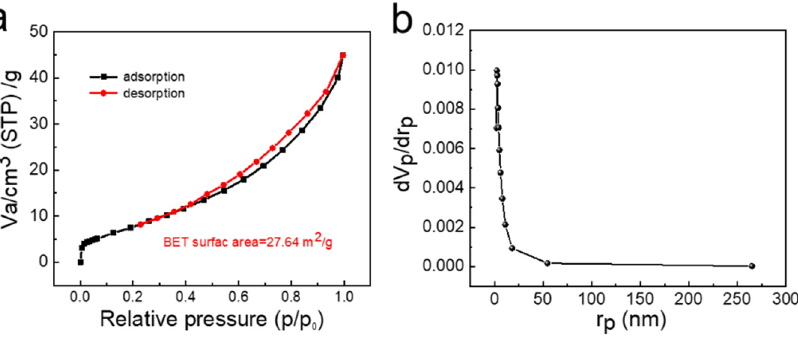
Figure 7. ( a ) N 2 adsorption-desorption isotherms and ( b ) pore size distribution of zeolite A.